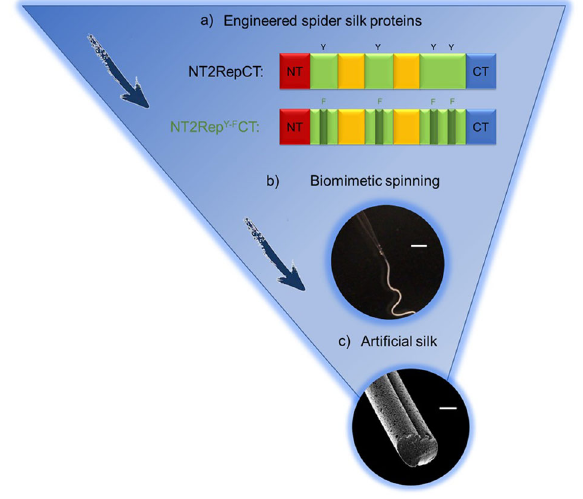
Fig. 1 Schematic presentation of the two designed spider silk proteins used in the study and biomimetic spinning of these into fi bers. a The two arti fi cial spider silk proteins studied in this work: NT2RepCT and the NT2Rep Y-F CT. b Formation of the biomimetic fi bers when entering the spinning bath. Scale bar: 2 mm. c FE-SEM picture of the fracture section of the NT2RepCT fi ber. Scale bar: 10 μ Results Arti fi cial spider silk dope made from 300 mg/mL NT2RepCT and NT2Rep Y-F CT (Fig. 1a), respectively, was extruded through a thin glass capillary into a pH 5 aqueous buffer as described previously 55 (Fig. 1b). Fibers were pulled up from the buffer and collected onto a motorized collection wheel 56 and dried in air under ambient conditions. To study supercontraction, the fi bers were mounted restrained in one end in a humidity chamber. The length and the diameter of ten fi bers per type (NT2RepCT and NT2Rep Y-F CT, respectively) were measured before putting the fi ber in the chamber and after 2 h at a fi xed relative humidity. that was positively correlated to relative humidity (Fig. 2 and